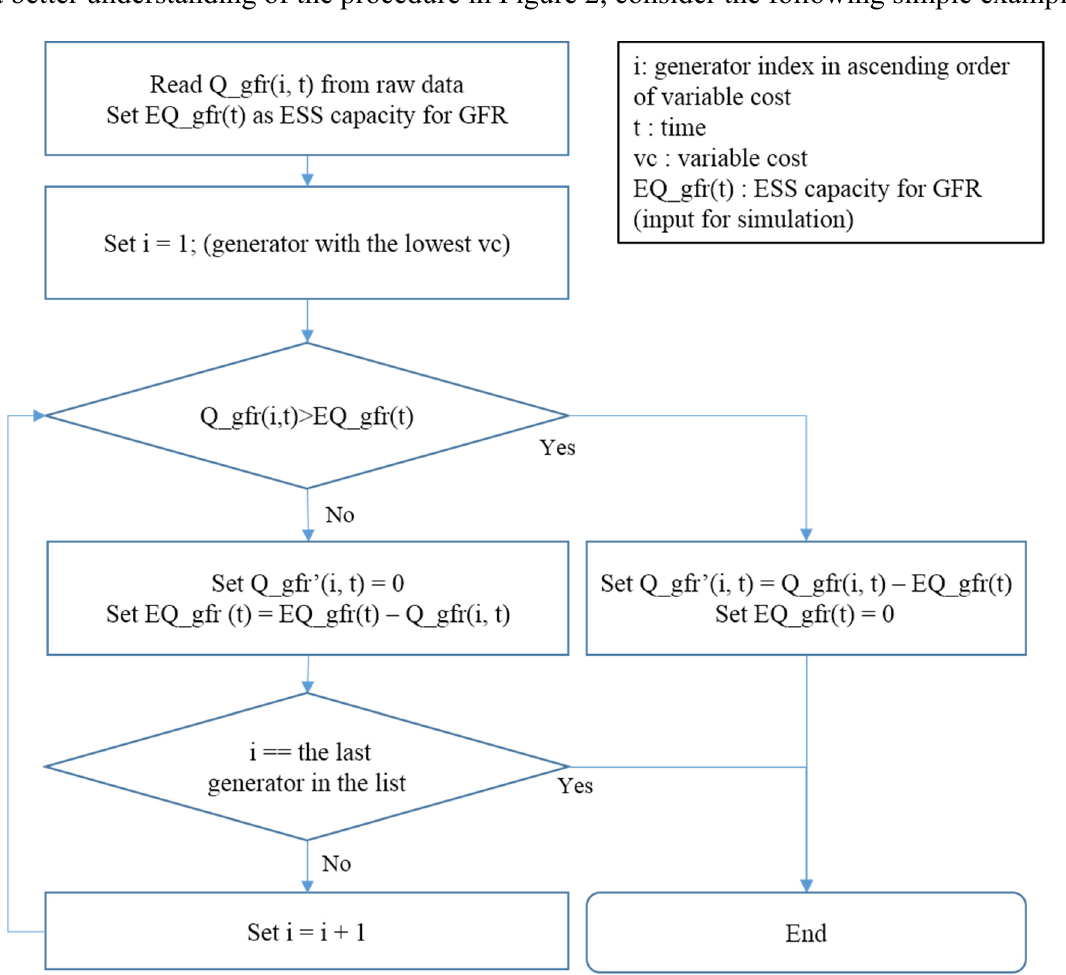
Figure 2. Calculating Q_coff